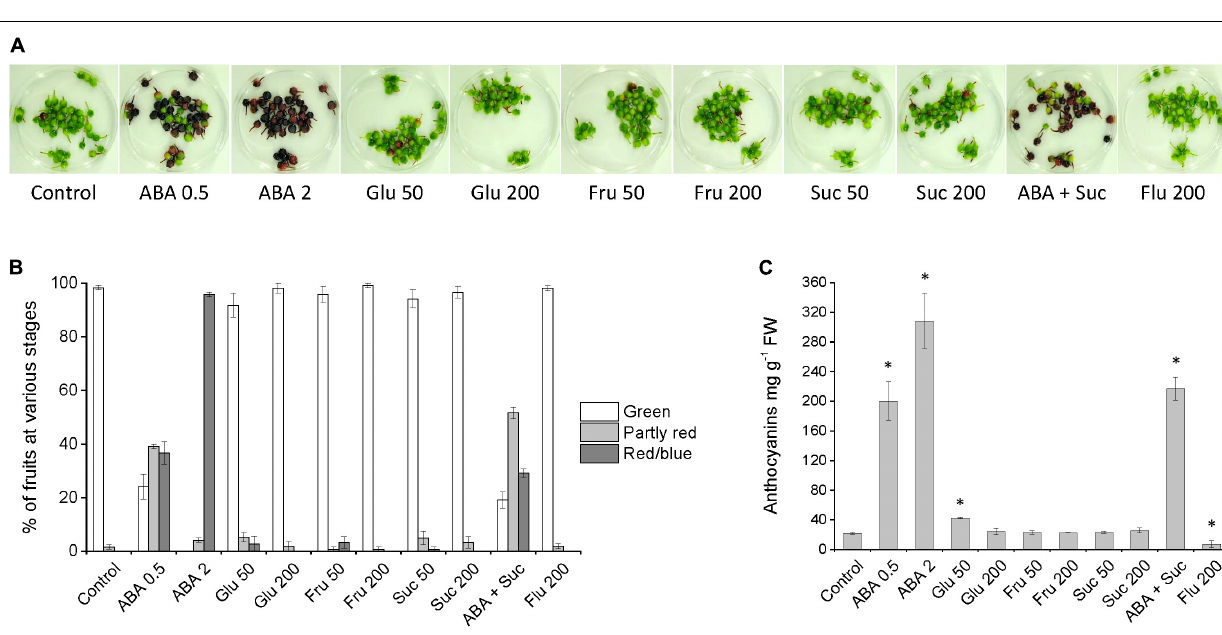
FIGURE 3 | Effect of post-harvest ABA and sugar treatments on bilberry fruit color and anthocyanin accumulation. Detached unripe green berries were immersed into solutions containing ABA (0.5 and 2 mM), glucose (50 and 200 mM), fructose (50 and 200 mM), sucrose (50 and 200 mM), 0.5 mM ABA + 200 mM sucrose, 200 µ M fluridone or water (control). After 4 days from the beginning of the experiment, fruits in Petri plates (A) were evaluated for their color (B) and measured for their anthocyanin content (C) . Total anthocyanin content is expressed as milligrams of cyanidin-3-glucoside equivalents g - 1 FW. Values represent means ± SEs of three replicates. Asterisks indicate significant differences from control in Student’s t -Test ( P ≤